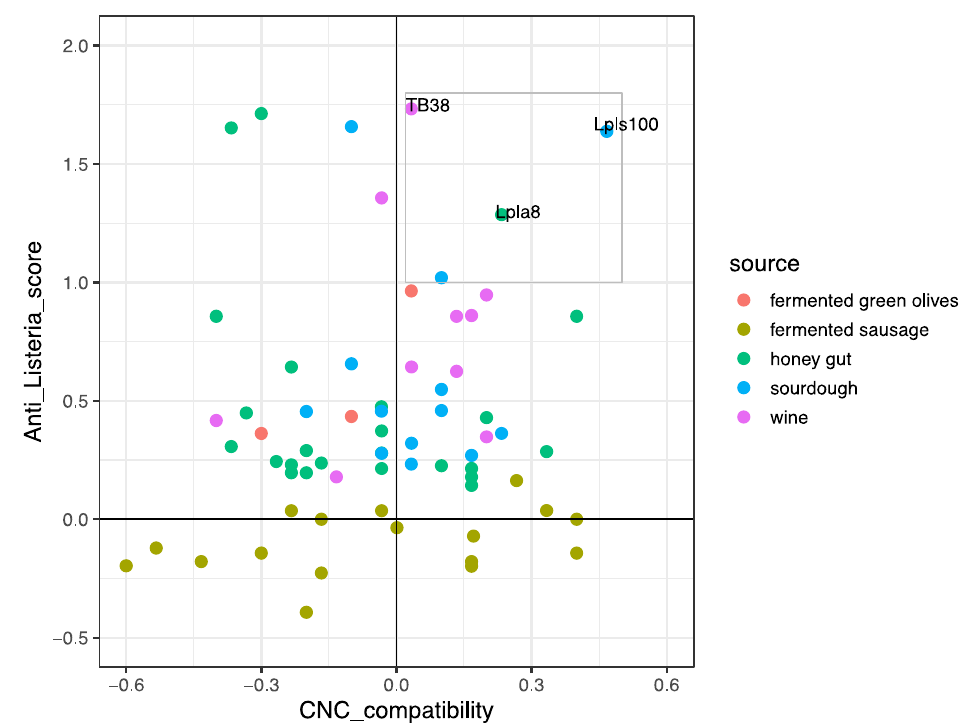
Figure 3. Scatterplot comparing the indexes CNC_compatibility and Anti_ Listeria _score of sixty-seven strains of Lactiplantibacillus plantarum isolated from di ff erent sources. The grey box encloses the strains with the two highest indexes.